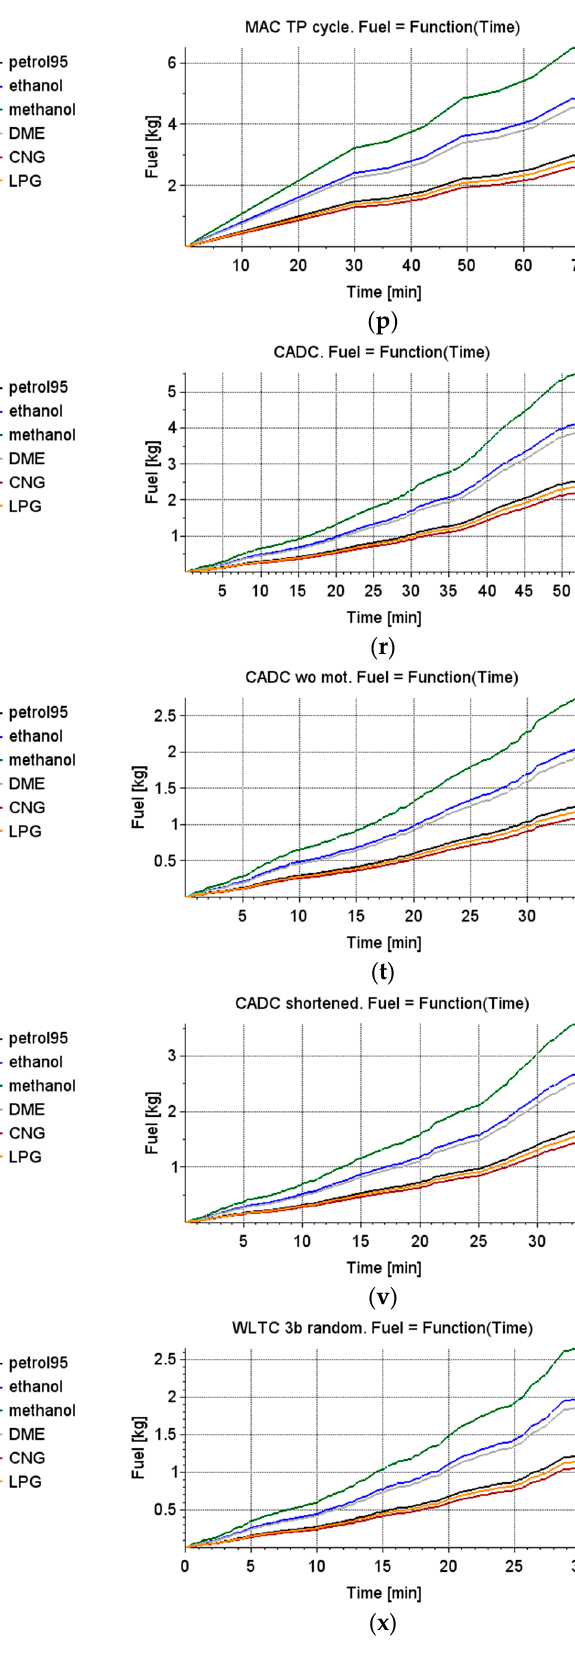
Figure 10. Results of the simulation of the stream and final fuel consumption for selected driving tests and selected fuels for the Toyota Camry LE 2018 vehicle: ( a ) waveforms of the instantaneous values of the fuel stream powering the